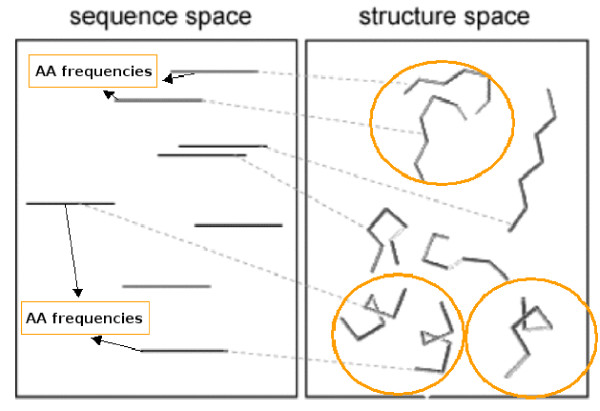
Clustering in structure space and generating sequence profiles for each structural cluster for Naive Bayes classification (Hunter's Method).